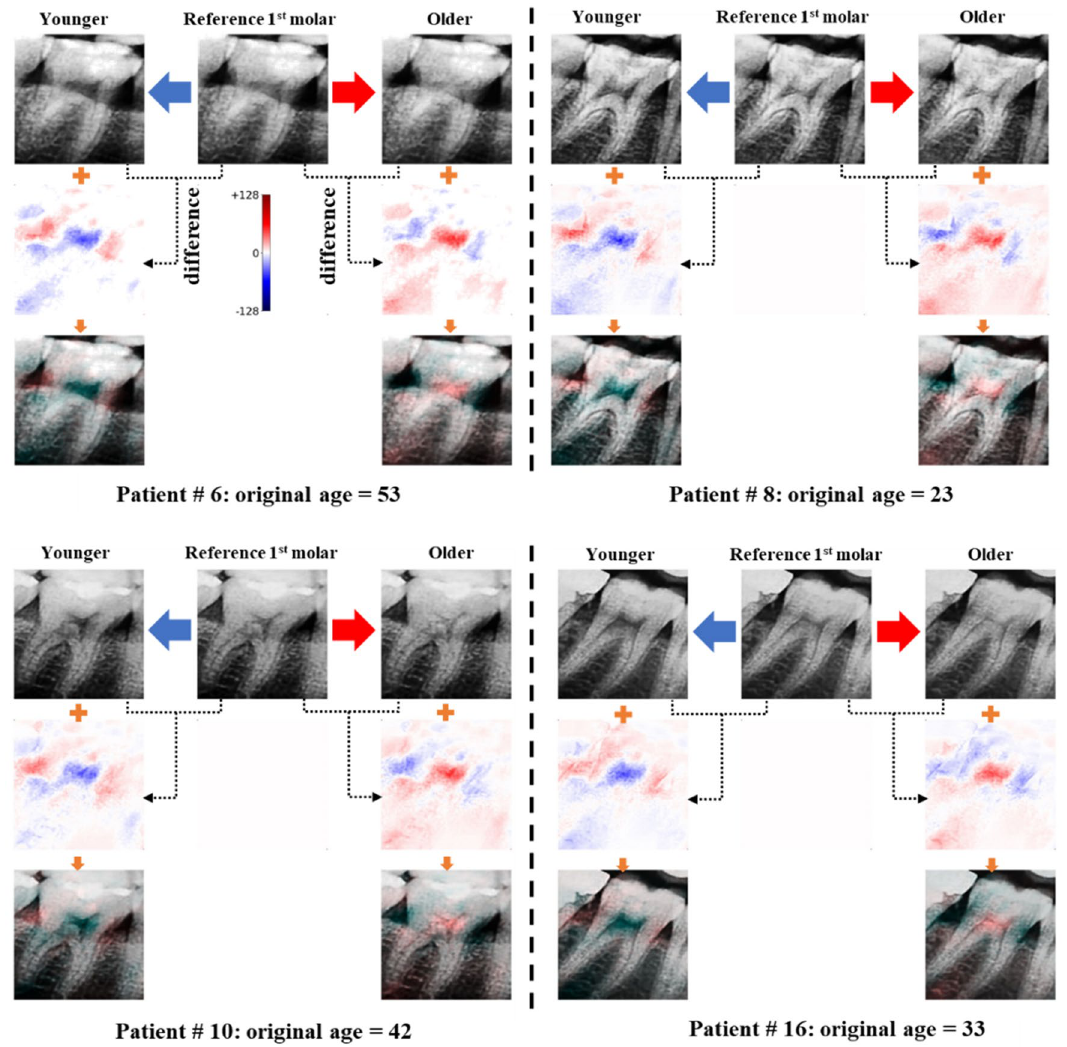
Figure 5. An example of the color maps that represent the correlation between advancing age and the morphological changes in teeth, prepared by generating virtual teeth images when the subject was younger or older using the developed VAE and linear regression model. The images in the first row are virtual images generated by controlling the latent variables of first molar teeth. The images in the second row are images in which the pixel difference between the original image and the virtual image generated by increasing or decreasing the age is expressed as different colors in the form of a diverging color map. Here, colors with higher intensity indicate that the corresponding regions have a stronger correlation with age. The images in the third row are those generated by overlaying the obtained color maps onto the corresponding teeth images to allow a quantitative analysis of the morphological changes in teeth with